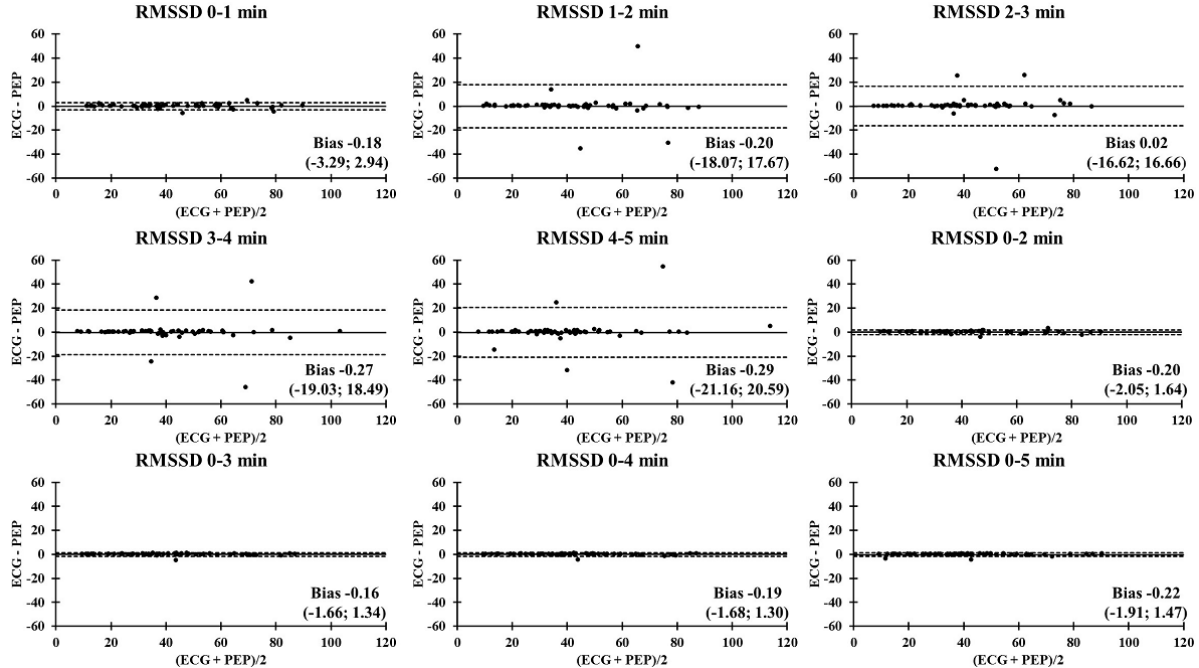
Figure 5. Bland-Altman analysis comparing the ECG and Pulse Express PRO measurements in ultra–short-term and short-term recordings of root mean square of successive R-R interval (RMSSD). The solid line represents the mean difference and the upper and lower dashed lines represent the upper and lower limits of agreement (± 1.96*SD). ECG: electrocardiogram; PEP: Pulse Express